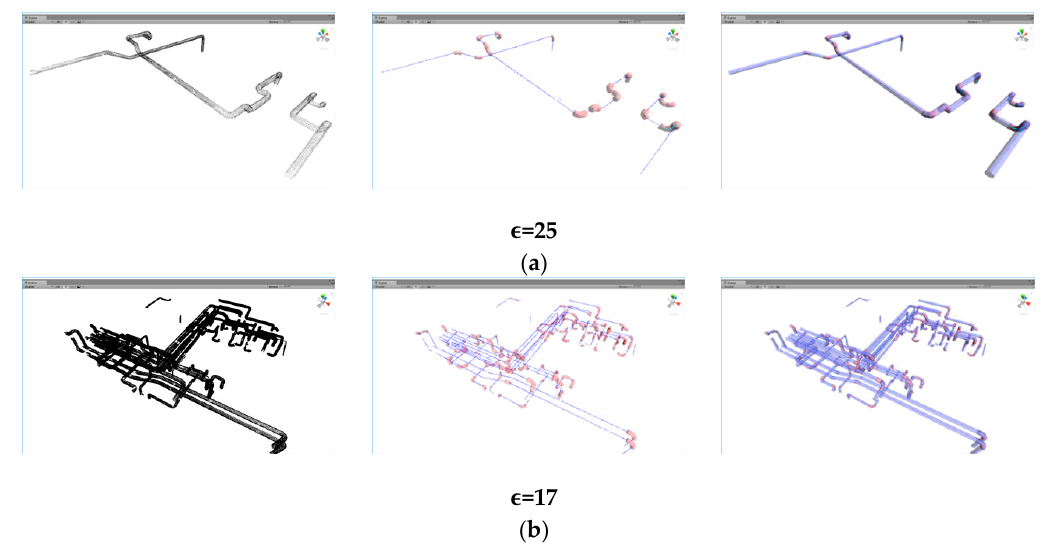
Figure 11. Estimation from segmented data with ϵ . From the left: point cloud/curved, center axis/straight, and curved areas: ( a ) simple data; ( b ) complicated data.